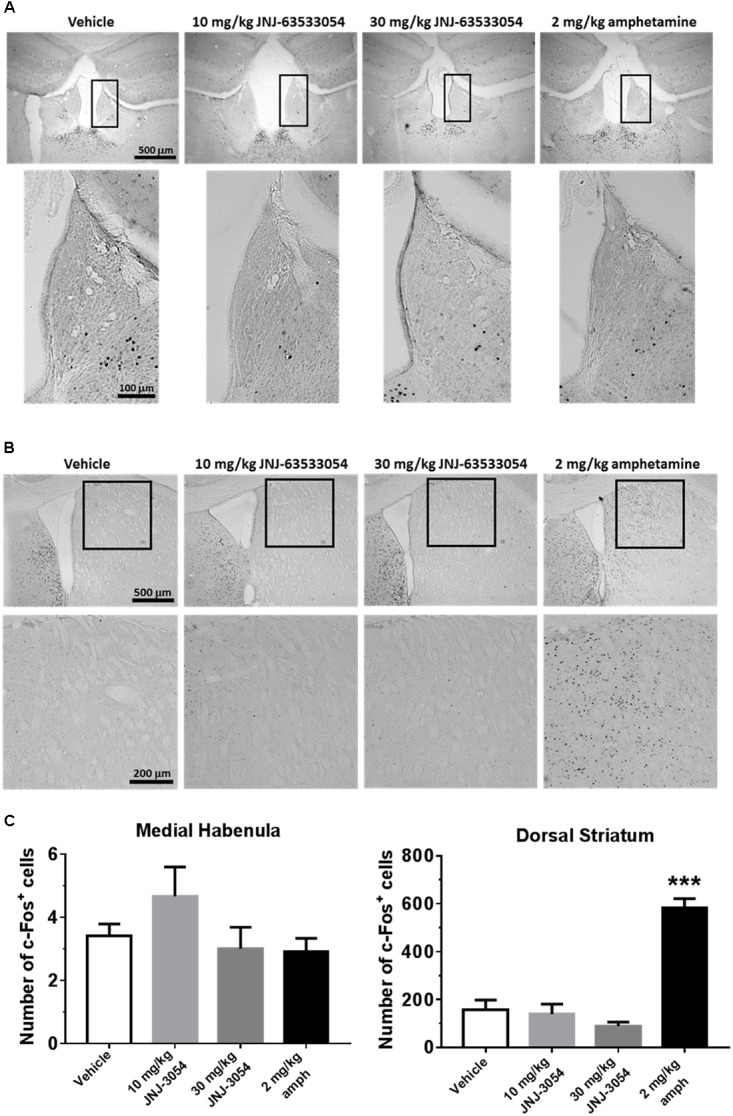
Mouse brain sections immunostained for c-fos expression in medial habenula (A) or dorsal striatum (B). Analysis of c-fos expression data (C; mean ± SEM). Neither JNJ-63533054 (10 or 30 mg/kg, p.o.) nor amphetamine (2 mg/kg, i.p.) had an effect on c-fos levels in the medial habenula (boxed regions) at 1 h post-injection. As a positive control, amphetamine increased c-fos in dorsal striatum, while JNJ-63533054 was again without effect. ∗∗∗p < 0.0001; n = 4 mice per treatment group.